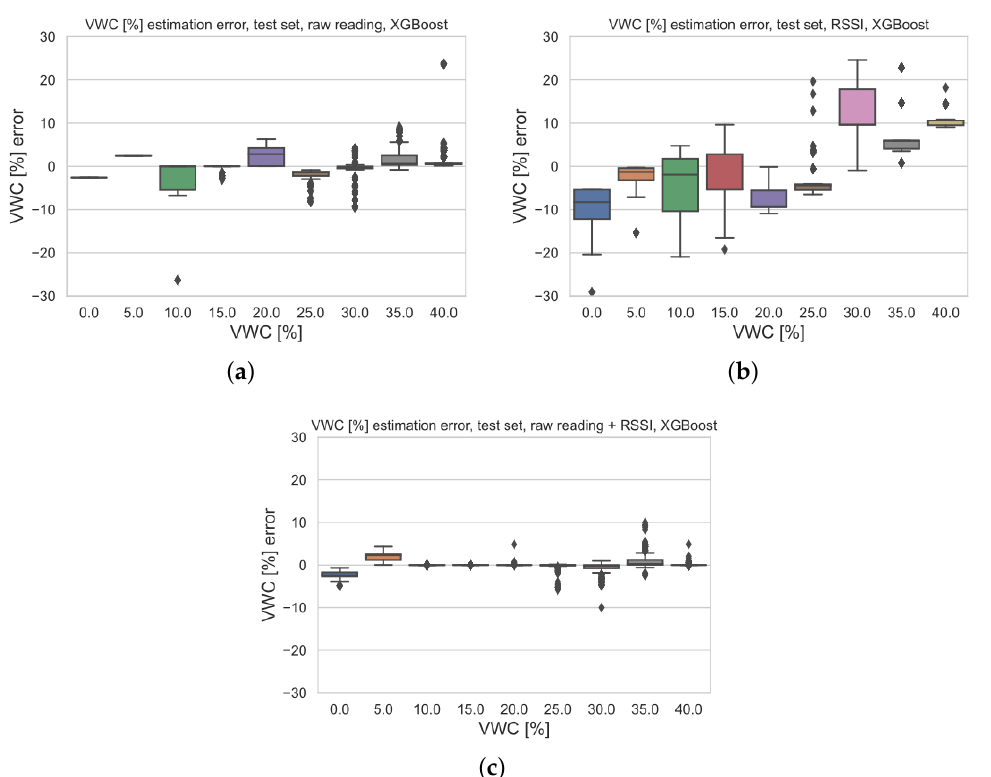
Figure 10. VWC estimation errors on test set for the three model versions: ( a ) calibrated real sensor relying only on raw readings, ( b ) virtual sensor taking as input RSSIs, and ( c ) augmented sensor grounded on both raw readings and RSSIs. Each colour in the picture stands for a different level of